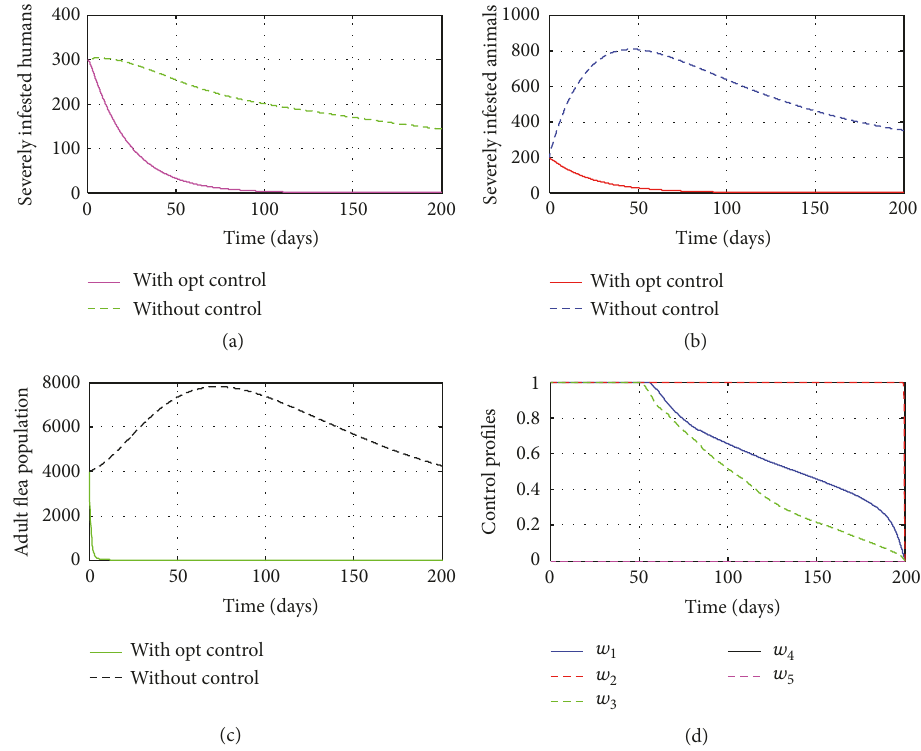
Figure 7: Optimal solutions for model variables 𝐼 𝐻ℎ , 𝐼 𝐴ℎ , 𝐹 𝐸 and the control profiles for 𝑤 1 , 𝑤 2 , 𝑤 3 , 𝑤 4 , 𝑤 5 with (𝑤 1 , 𝑤 2 ,𝑤 3 ̸= 0) .